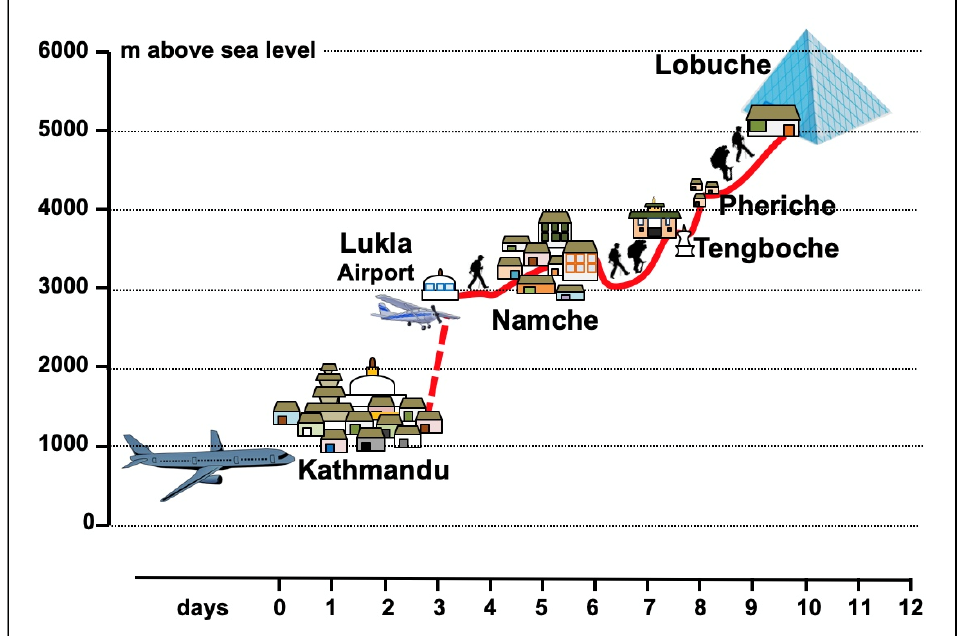
Figure 1. Timing, altimetry, and steps of the scientific expedition.